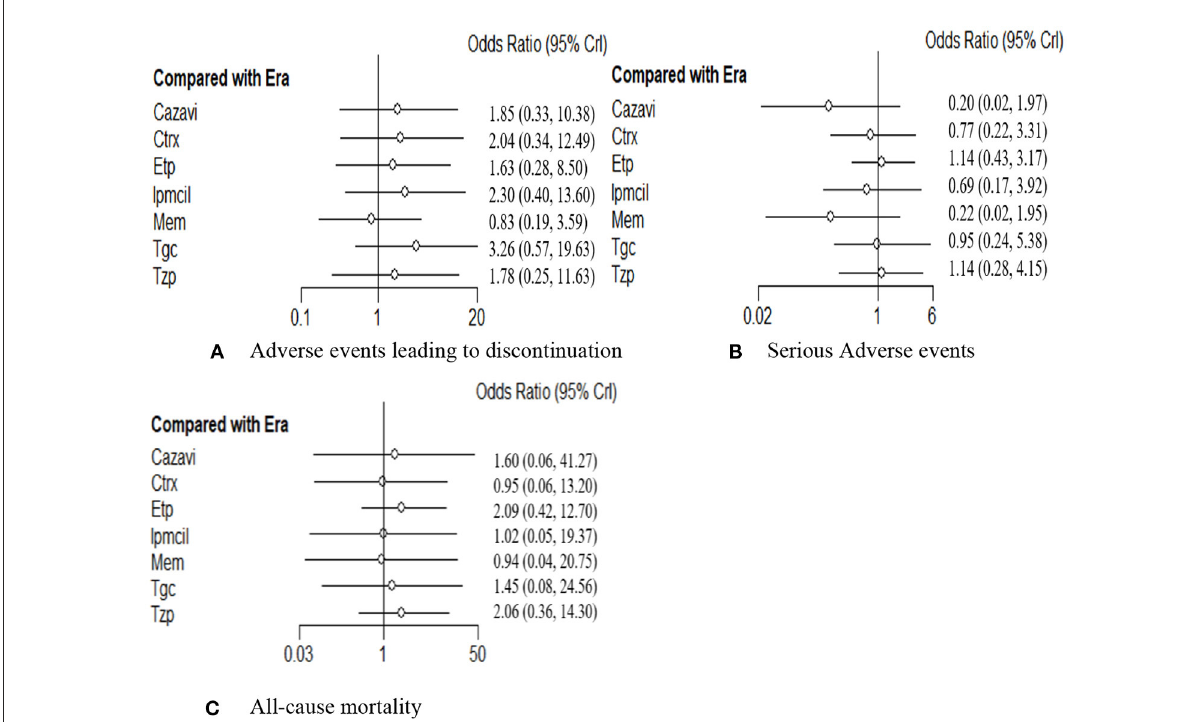
FIGURE5 (A–C) Forest plot for safety endpoints. ITT, intention-to-treat; CE, clinical evaluate; ME, microbiological evaluable; Era, eravacycline; Etp, ertapenem; Mem, meropenem; Tgc, tigecycline; Cazavi, ceftazidime/avibactam + metronidazole; Tzp, piperacillin/tazobactam; Ctrx, ceftriaxone + metronidazole; Ipmcil,